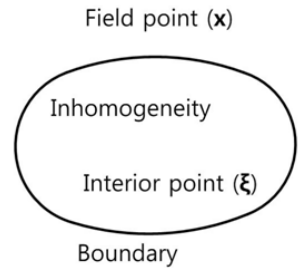
Figure 3. The field point and the interior point (including the boundary point).